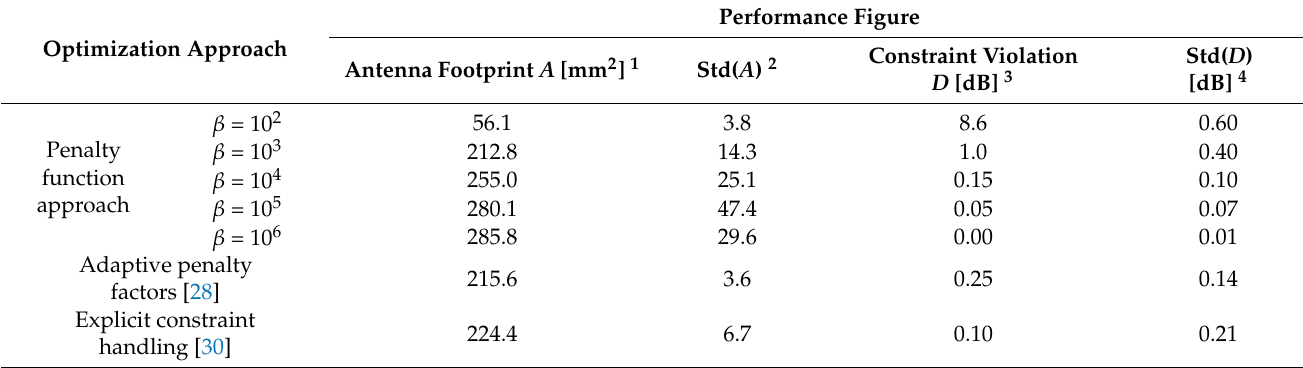
Table 3. Optimization results for antenna of Figure 11.